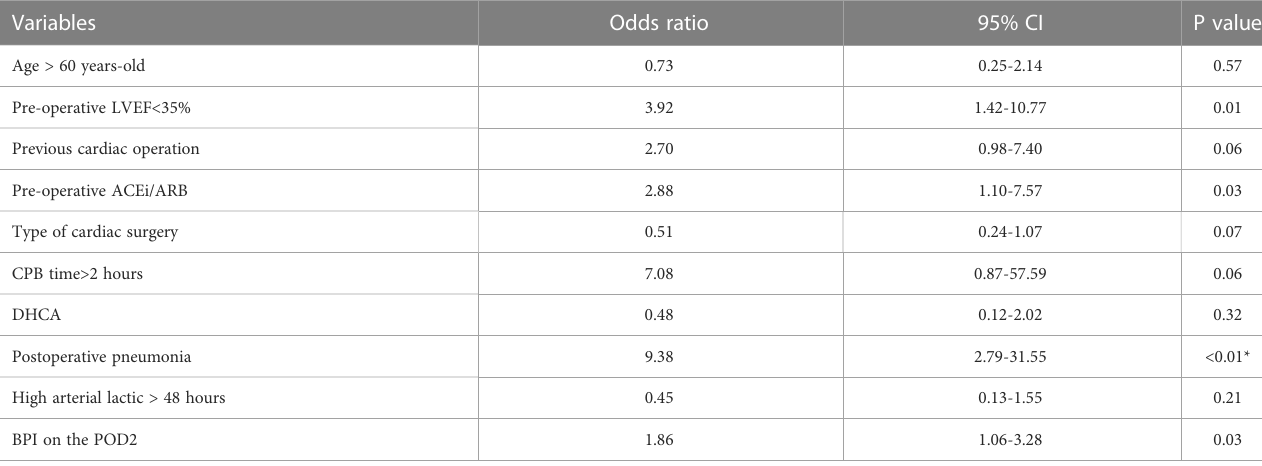
TABLE 3 Multivariable logistic regression in pre-propensity matched patients.